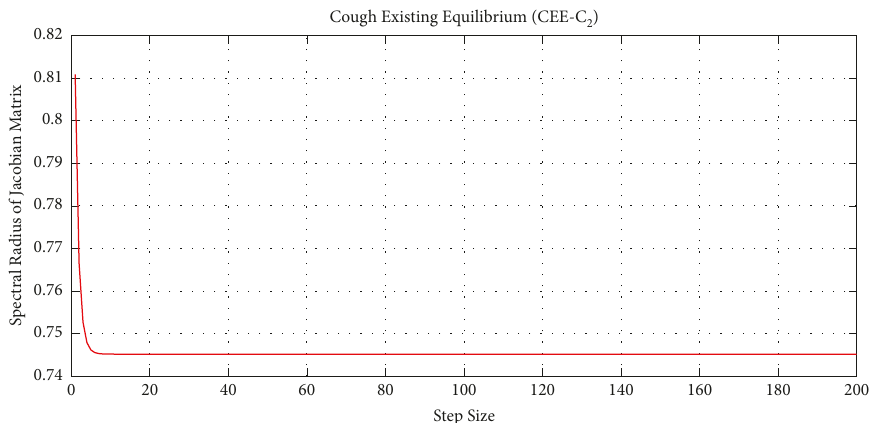
Figure 2: Largest Eigenvalue of the system at the equilibria C